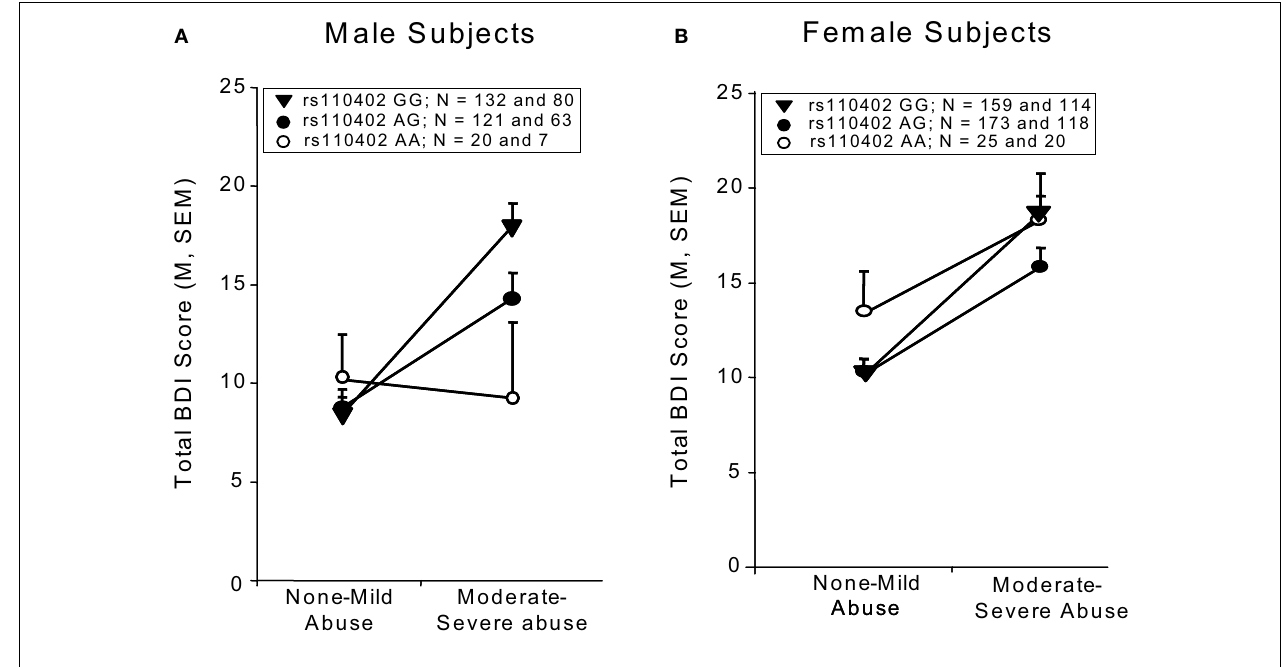
FIGURE 1 | Interaction of CRHR1 rs110402 genotype and childhood abuse ( F = 3.50, p = 0.031) on BDI scores. (B) In women, there was a signifi cant 2,423 exposure on current depressive symptoms in men ( N = 424) and women main effect of childhood abuse exposure on BDI score ( F ( N = 635). Graph depicts mean (SEM) total BDI scores in subjects grouped p < 0.0001), but no signifi cant gene-environment interaction of rs110402 and according to rs110402 allele status (GG, AG, AA) and exposure to none-mild childhood abuse exposure on BDI scores. The genotype distribution is given in versus moderate-severe childhood abuse. (A) In men, there was a signifi cant the fi gure legend, with the fi rst number representing the N in the non-mild main effect of childhood abuse exposure ( F = 8.20, p = 0.004) and a abuse group and the second number the N in the moderate to severe abuse 1, 423 signifi cant interaction effect of rs110402 by childhood abuse exposure exposure